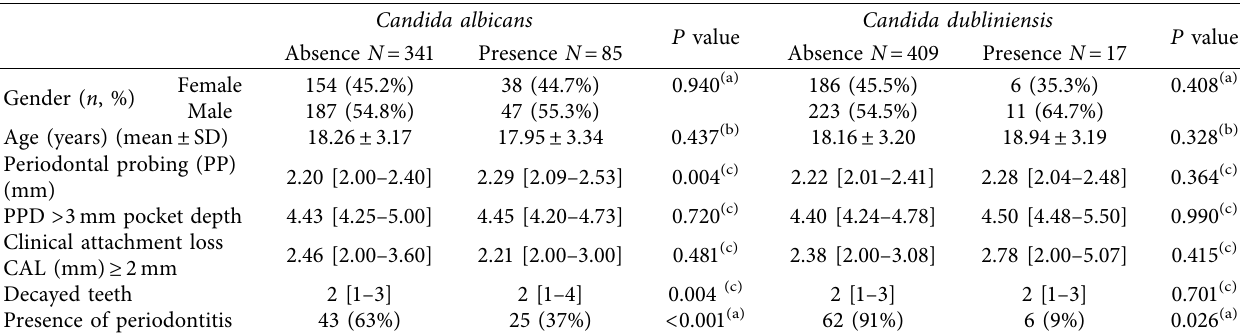
Table 2: The presence of Candida albicans and Candida dubliniensis according to sex, age, and clinical variables.